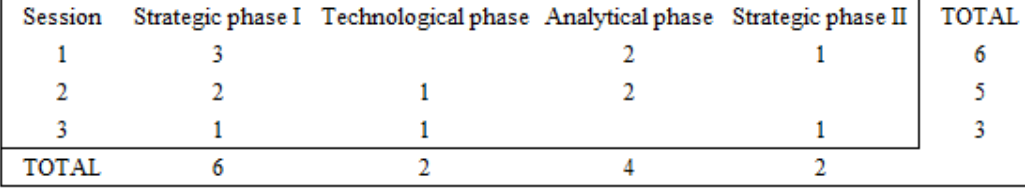
Figure 2. Suggestions for improvements made throughout the discussion.